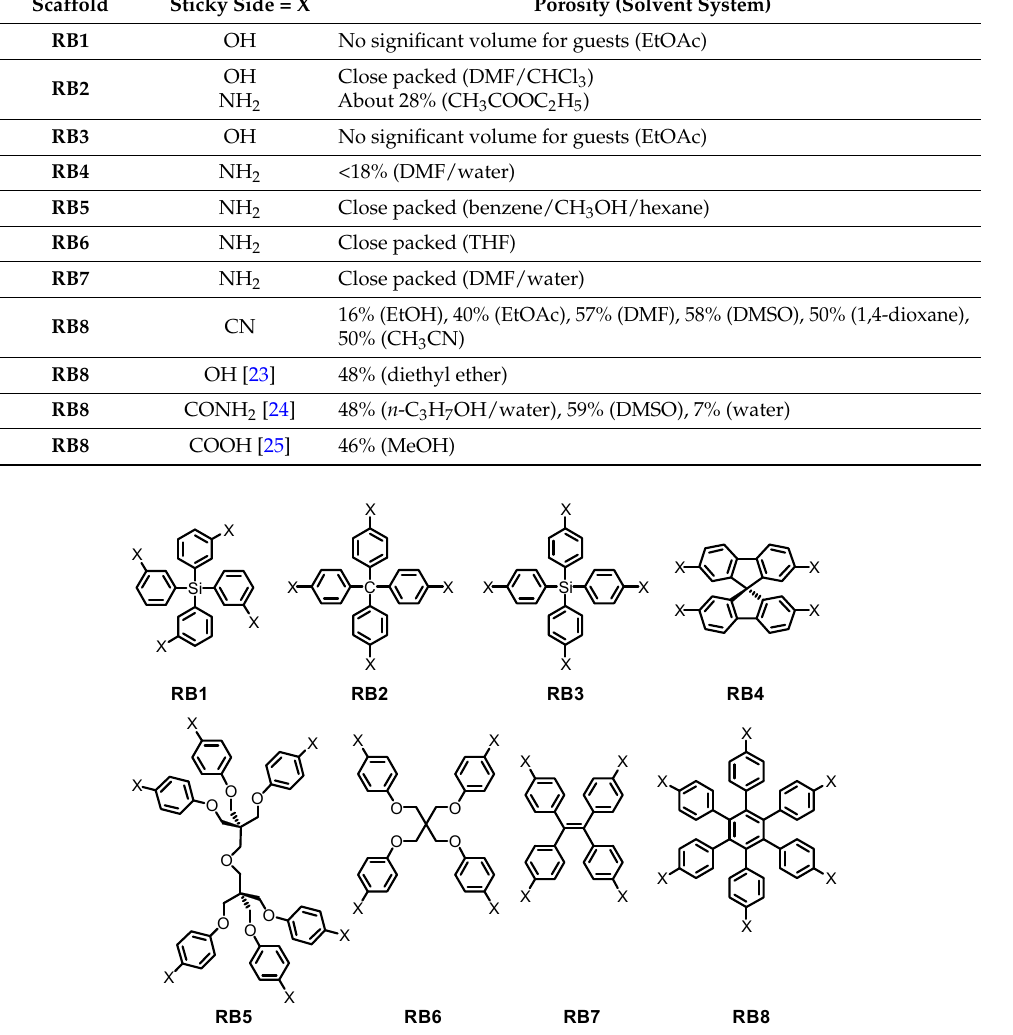
Table 1. Porosities of HOFs.